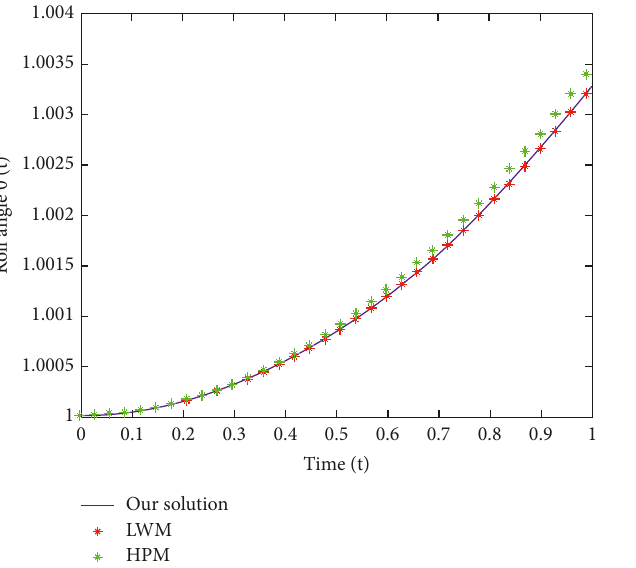
Figure 6: Comparative Study of Genocchi polynomial, LWM, and HPM for roll angle with respect to the time t (in sec) for Ex.6.